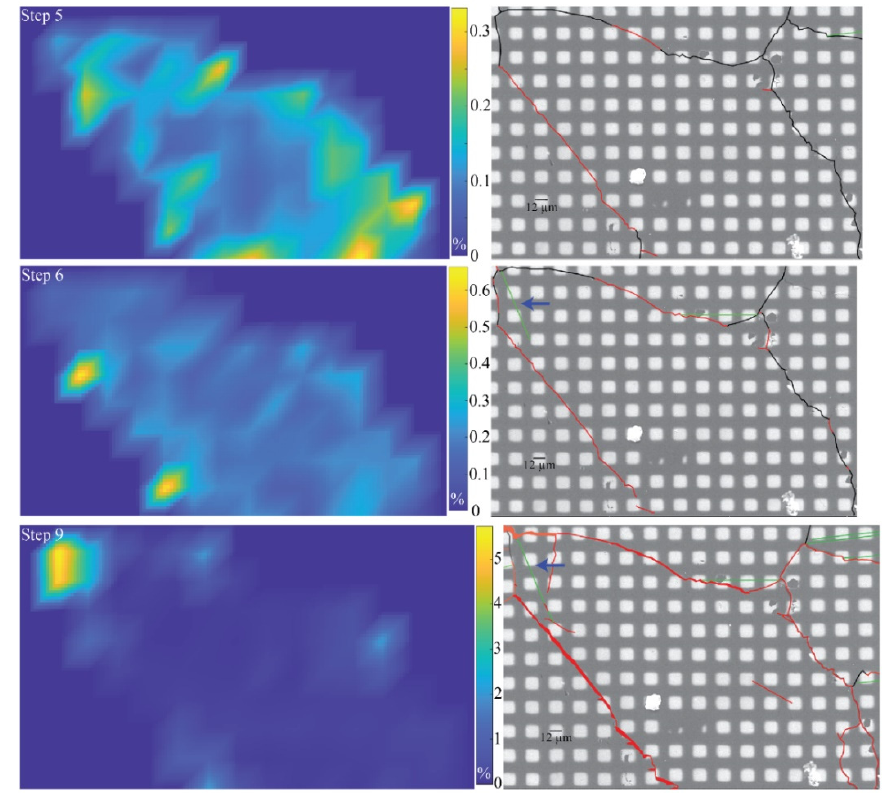
Figure 24. Equivalent Von Mises deformation map of crystal 18 at different steps of sample defor- mation. The black lines represent the grain boundaries. The green lines show the twinned planes. The red lines show the fracture zones. The blue arrow is indicating the location of the twinned